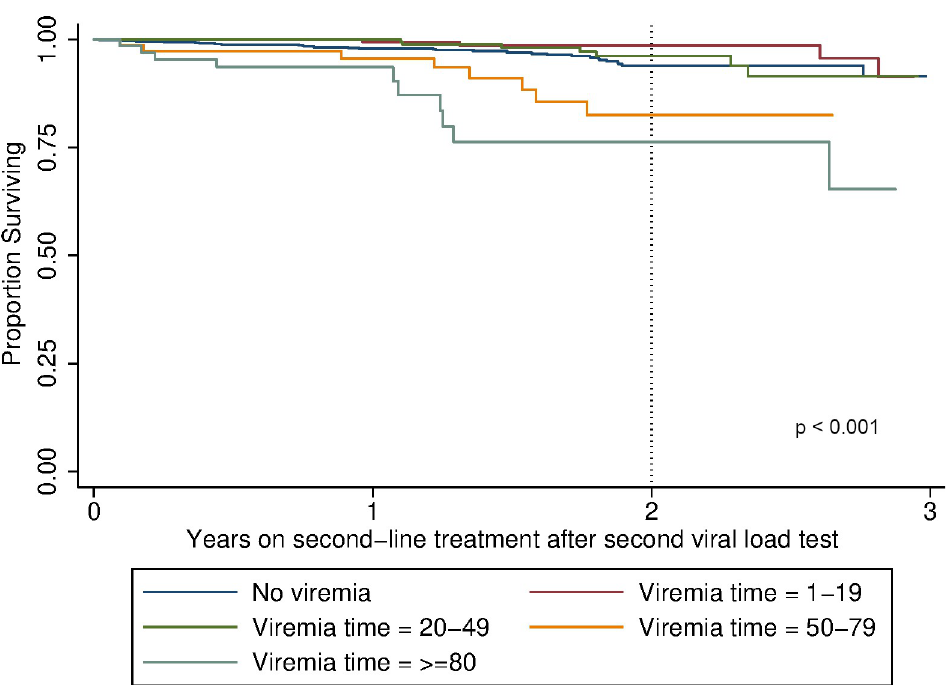
Fig 4. Kaplan-Meier survival estimates by